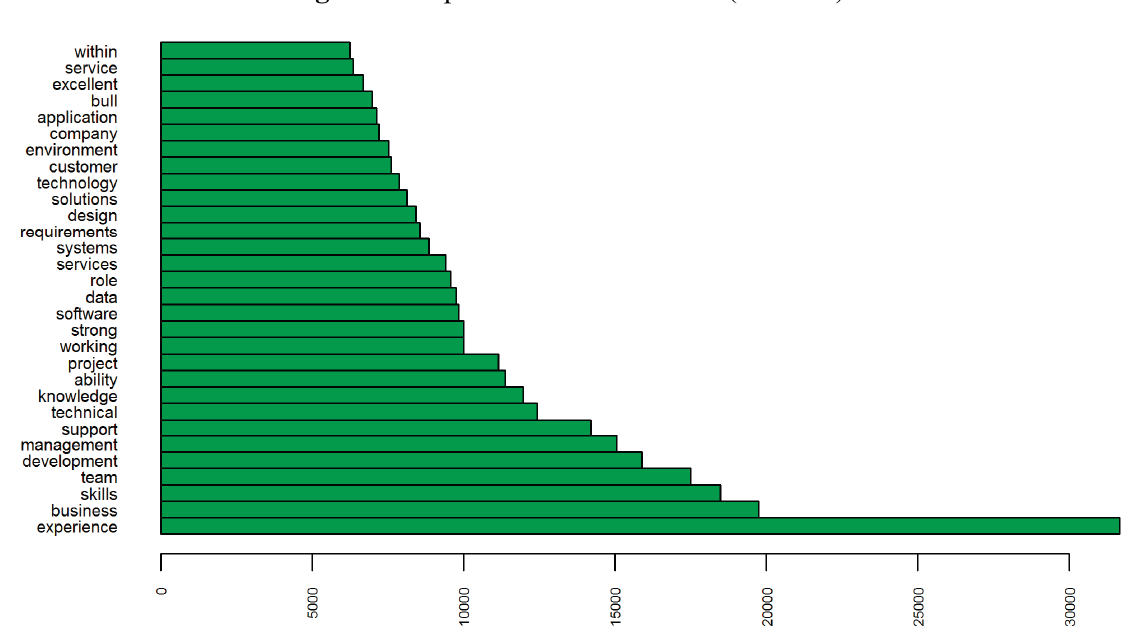
Figure 4. Top 30 terms—IT dataset